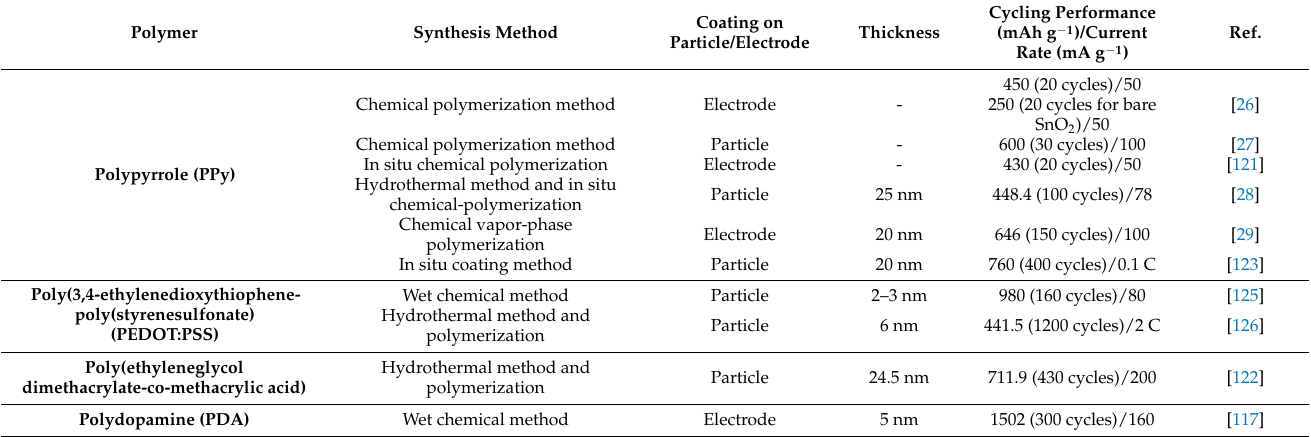
Figure 7. ( a ) The hydrothermal synthesis of PEDOT:PSS coated SnO 2 @C anodes. ( b , c ) TEM morphology of SnO 2 @C/PEDOT:PSS and bare SnO 2 @C after the cycling performance. ( d ) The SnO 2 @C/PEDOT:PSS composite anode cycling performances with rate cyclability at 2 C and CE. Reproduced from Ref. [126] with permission from Wiley. Table 2. Various polymer coatings applied to SnO 2 -based anodes and their electrochemical perfor- mances.